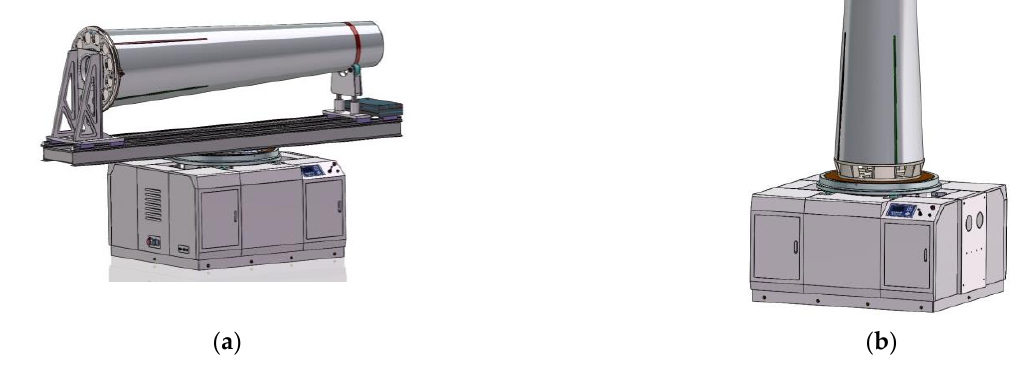
Figure 5. ( a ) Overall effect of the equipment — horizontal state; ( b ) overall effect of the equipment — vertical state.